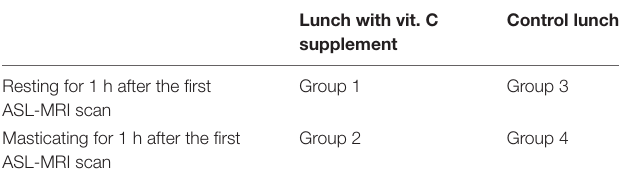
TABLE 1 | Synthesis of the experimental groups.